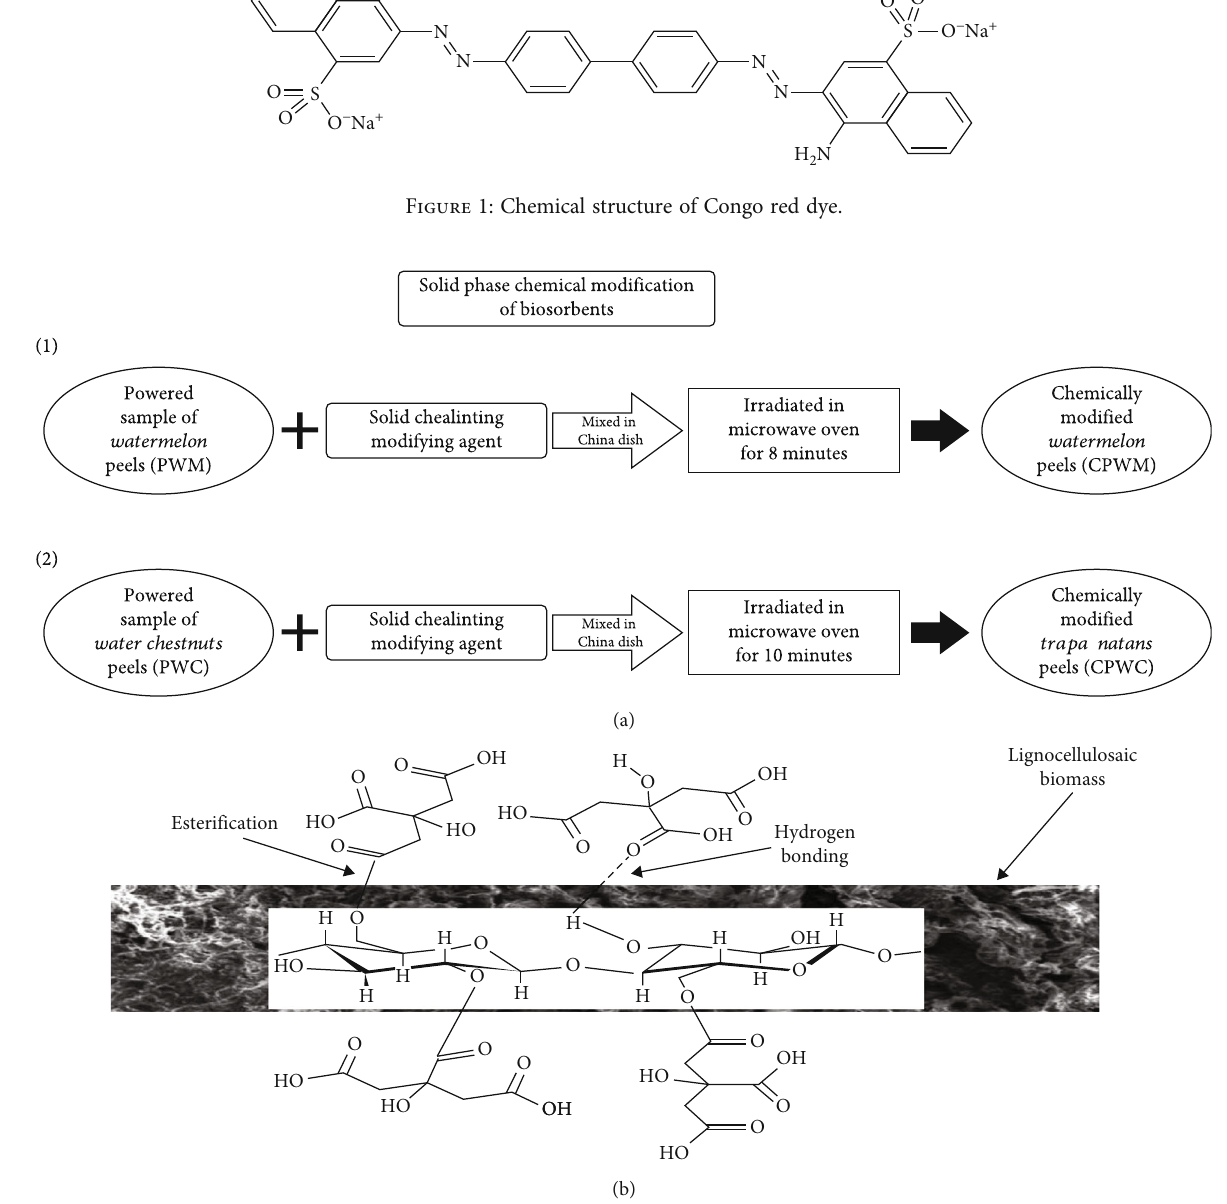
Figure 2: (a) Chemical modi fi cation scheme of adsorbents. (b) Illustration of chemically treated